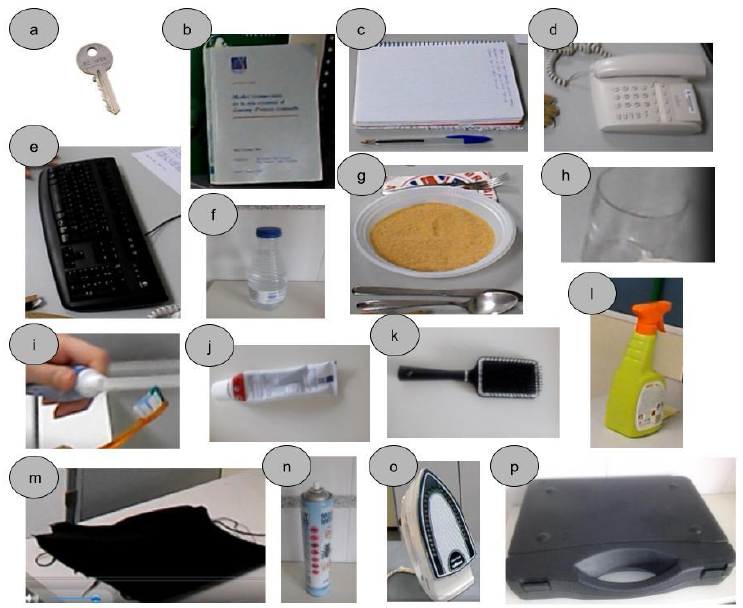
Figure 2. Objects used in the tasks: ( a ) key, ( b ) book, ( c ) pen, ( d ) phone, ( e ) keyboard, ( f ) bottle, ( g ) spoon, knife, fork, ( h ) glass, ( i ) toothbrush, ( j ) toothpaste tube, ( k ) comb, ( l ) pistol grip sprayer, ( m ) cleaning cloth, ( n ) aerosol can, ( o ) iron, ( p ) briefcase. Table 1. Task description grouped by setup used (see Figure 1), with indication of objects manipulated and subject’s posture. Objects Manipulated Task Description Setup Subject’s with Right Hand